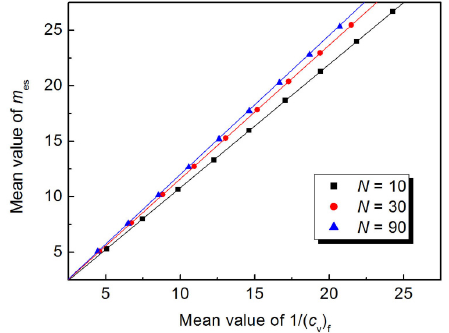
m with the mean es